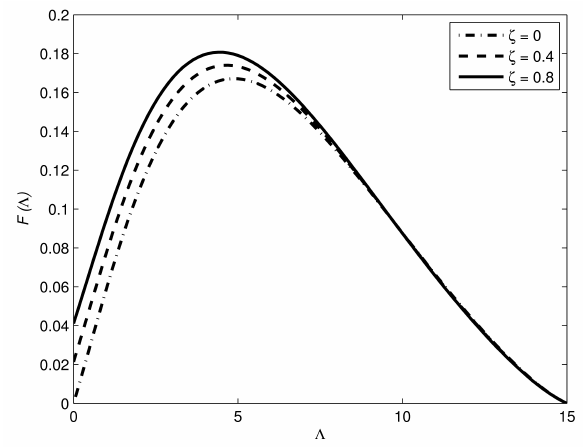
Figure 12: Effect of C 2 on − P ( Λ ) keeping ζ = η = 0.2 , C 1 = C 3 = 200 , Br = 1 , Pr = 6.8 and Re = 2950